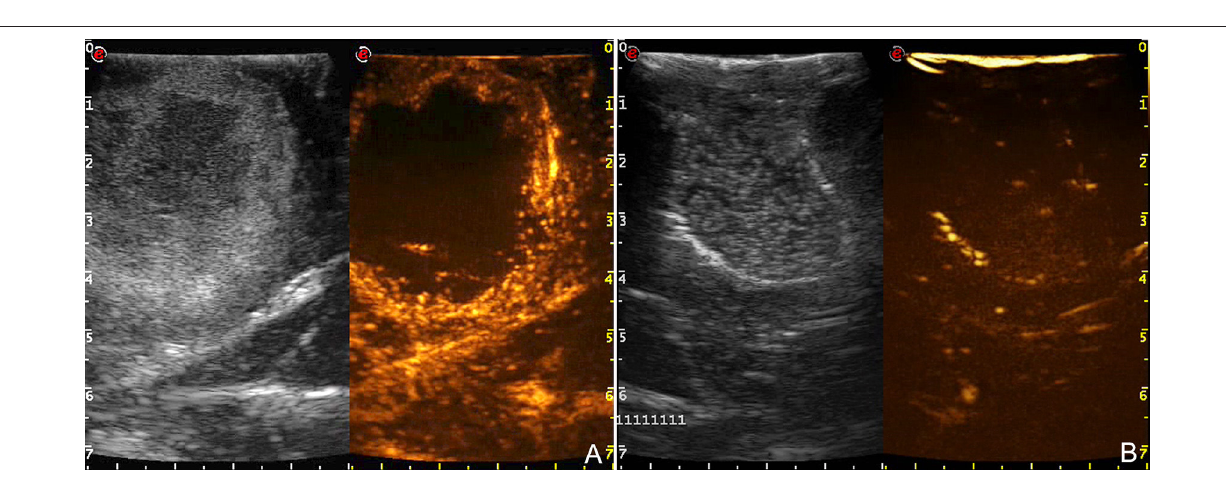
FIGURE 8 | Comparison between pre- (A) and post-resection (B) CEUS scans in a case of right temporo-parietal glioblastoma. After tumor removal, B-mode became difficult to understand because of surgical-induced artifacts whereas CEUS clearly demonstrates the presence of potential residual